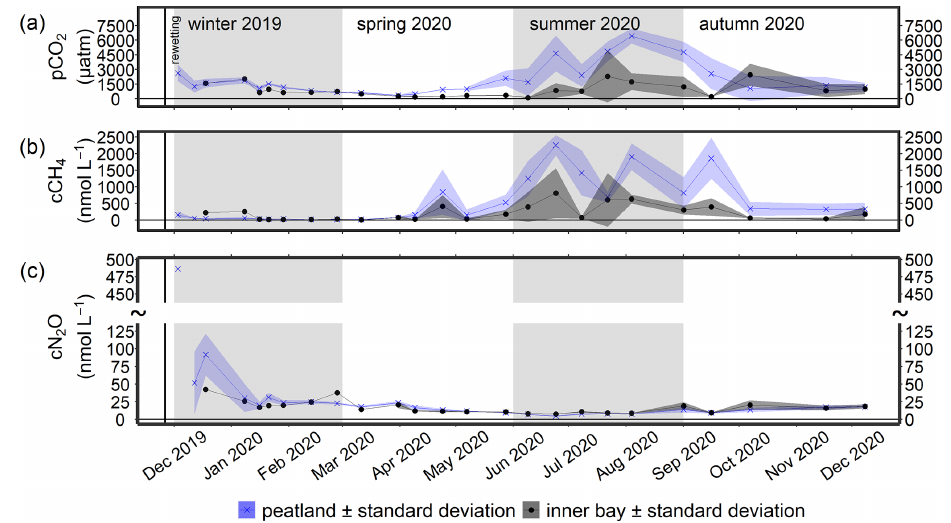
Figure 7. Time series of the mean (a) p CO 2 , (b) CH 4 concentration ( c CH 4 ), and (c) N 2 O concentration ( c N 2 O; ± standard deviation) after rewetting in the surface water from December 2019 to December 2020. Data from the flooded peatland ( n = 6) are shown in blue and data from the inner bay (until 11 March 2020, n = 1; thereafter, n = 2) in black. The vertical black line indicates the rewetting